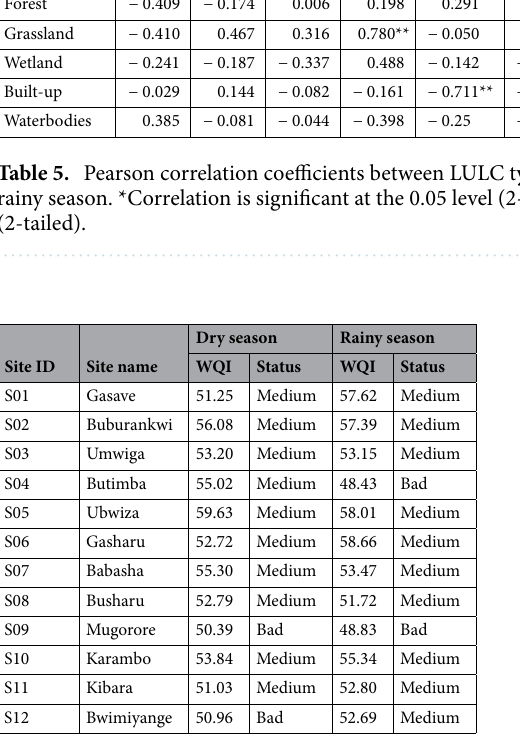
Table 6. The water quality status based on the NSFWQI during the dry and rainy seasons in Lake Muhazi.